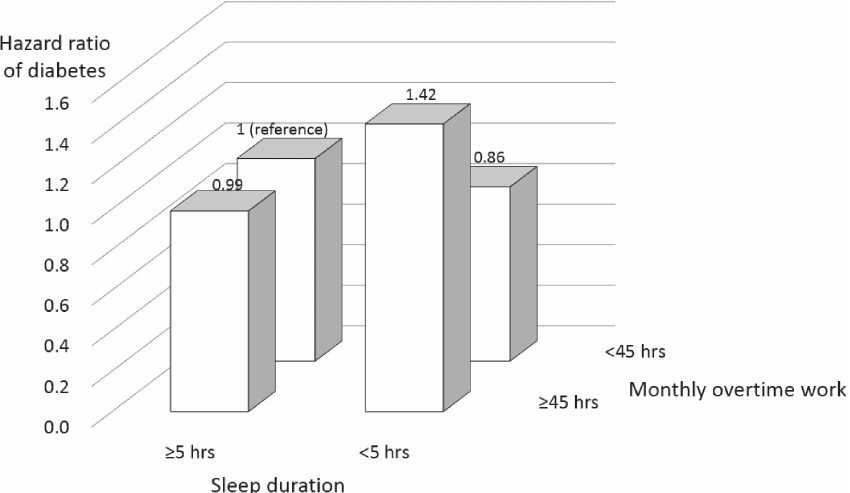
Figure 1. Combined association of overtime work and sleep duration with risk of type 2 diabetes. Data were adjusted for baseline variables, including age, sex, smoking, alcohol consumption, leisure-time exercise, occupational physical activity, shift work, job position, type of department, family history of diabetes, hypertension, body mass index, and HbA1c. HbA1c, glycated hemoglobin.